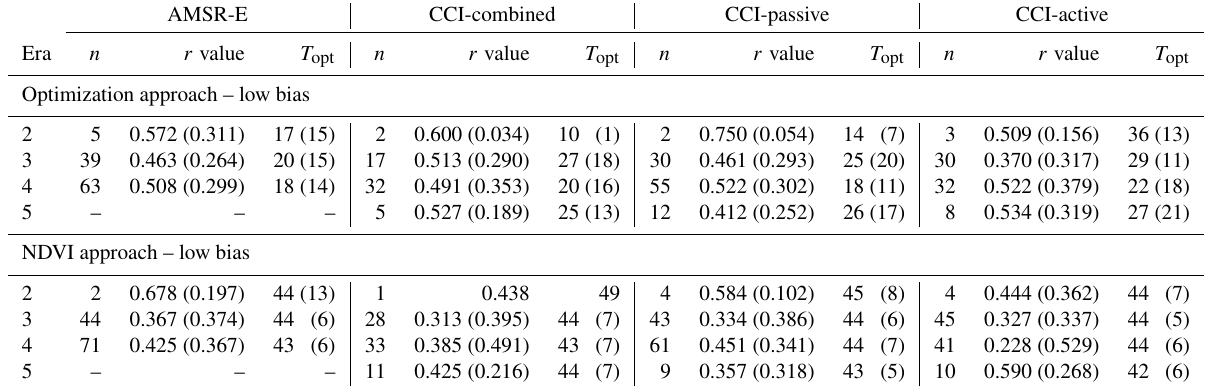
Table 5. Average lagged r values and T opt between SWI based on optimization and in situ soil moisture at the 20.32cm depth for the SNOTEL network. Standard derivation is indicated in parentheses. The n value represents the number of